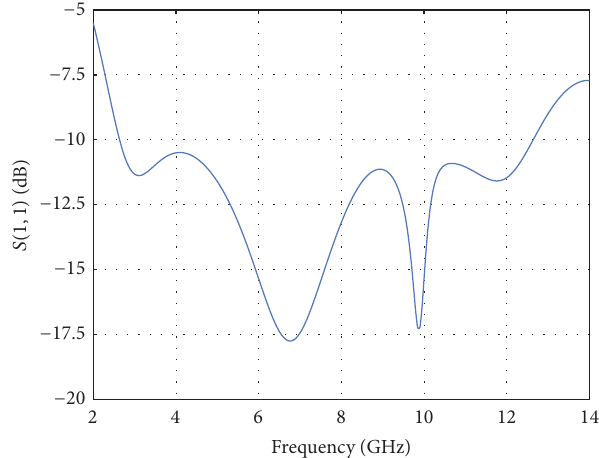
Figure 8: Antenna input reflection coefficient versus frequency of the final version of the UWB